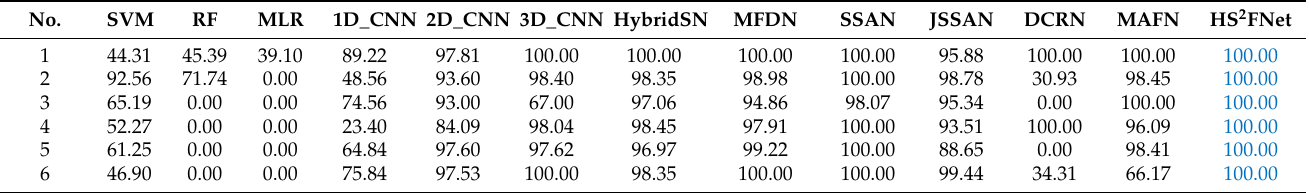
Table 6. Quantitative comparisons of the state-of-the-art models and our network on KSC